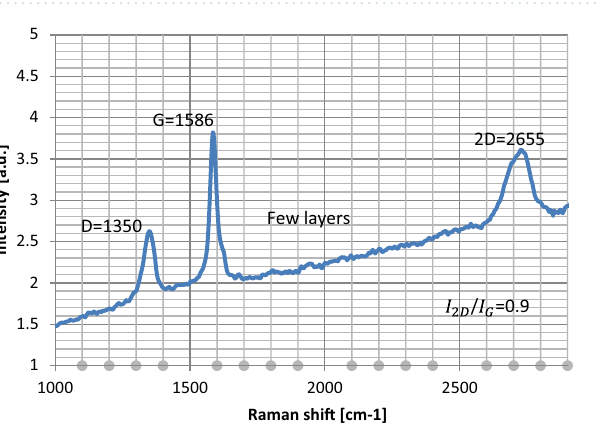
Figure 10. TEM micrographs of the exfoliated graphene flakes, scale bar: ( a ) 200 nm, ( b ) 100 nm.